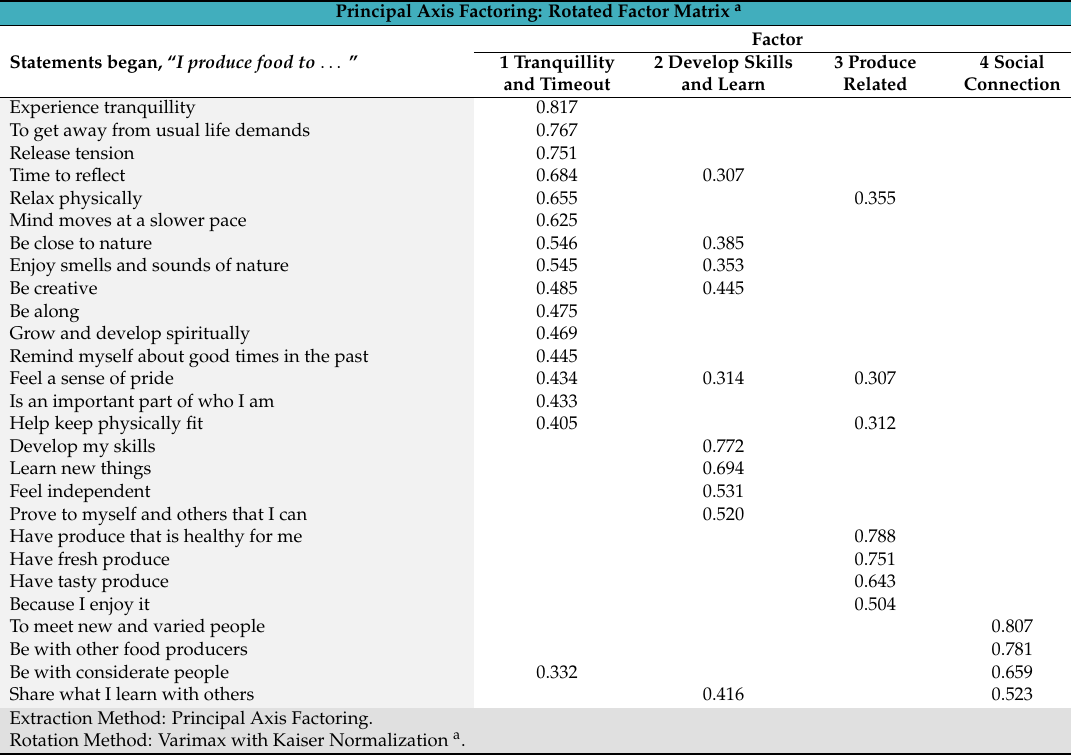
Table 3. Item loading from Principal Axis Factoring with Varimax Rotation and Kaiser Normalisation. Principal Axis Factoring: Rotated Factor Matrix